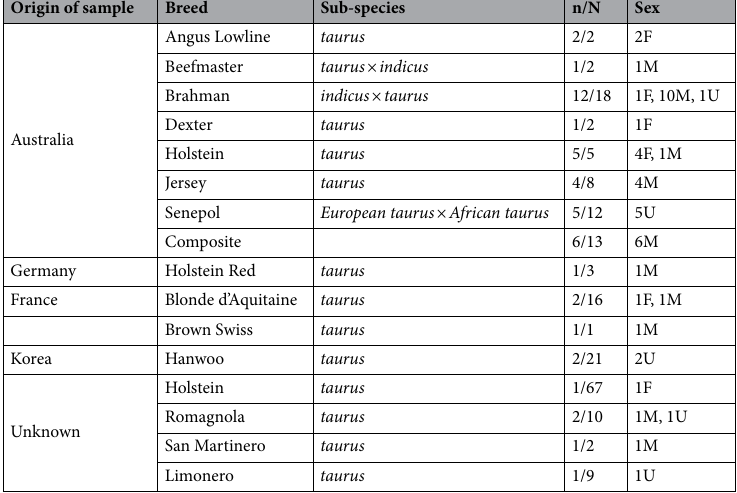
Table 3. Prevalence of T1 (African taurine ) haplogroup in non-African cattle breeds and composites. F female, M male, U unknown, n no. of animals showing T1 haplogroup, N no. of animals in a breed sampled from the specified country.